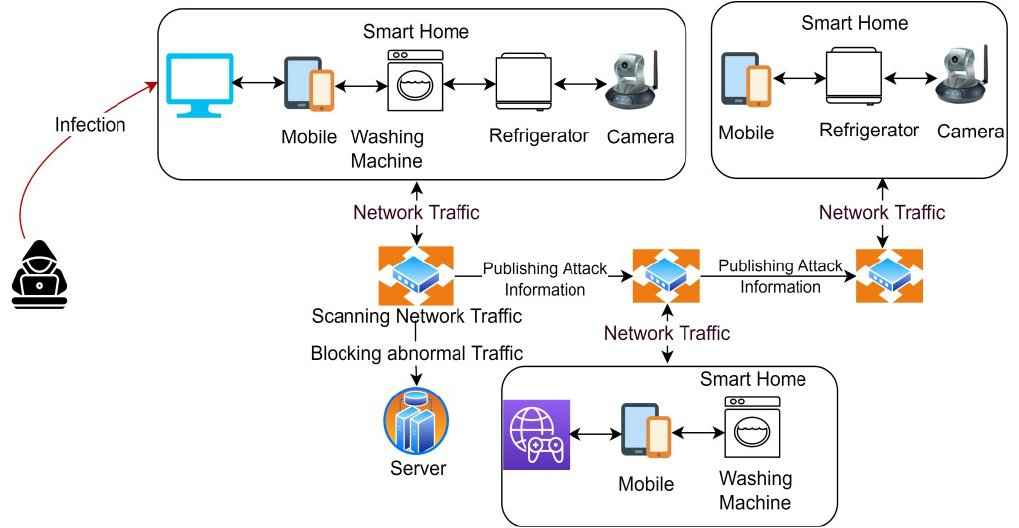
Figure 3. The detection scenario .